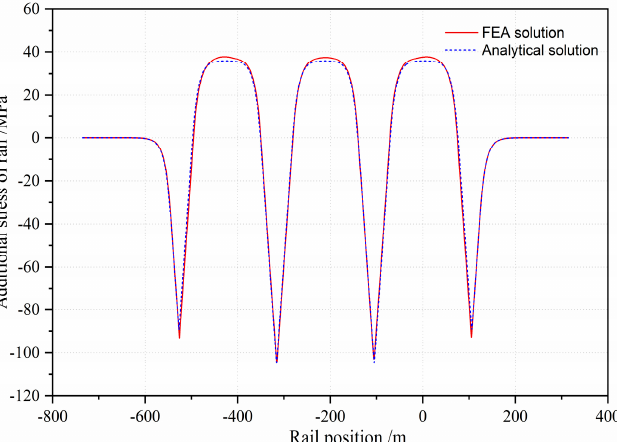
Figure 8. Comparison of the additional force of the rail according to finite element analysis (FEA) and the analytical solution .